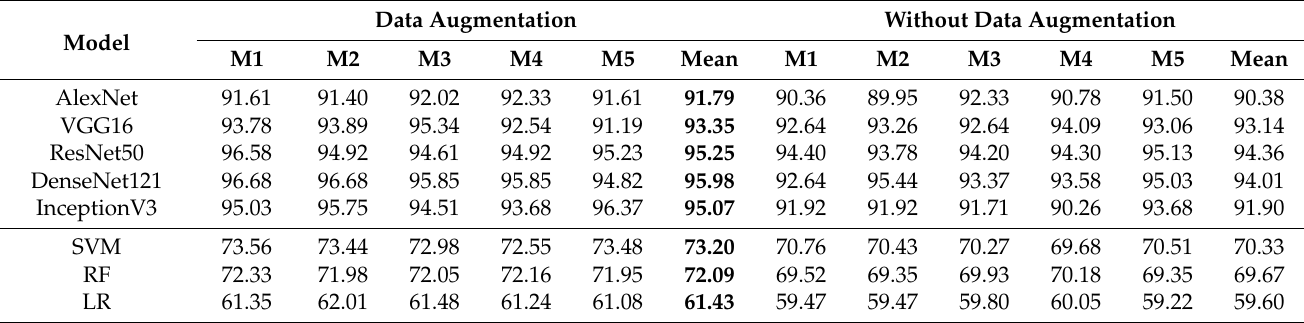
Table 2. Prediction accuracy of M models in deep learning and traditional machine learning.